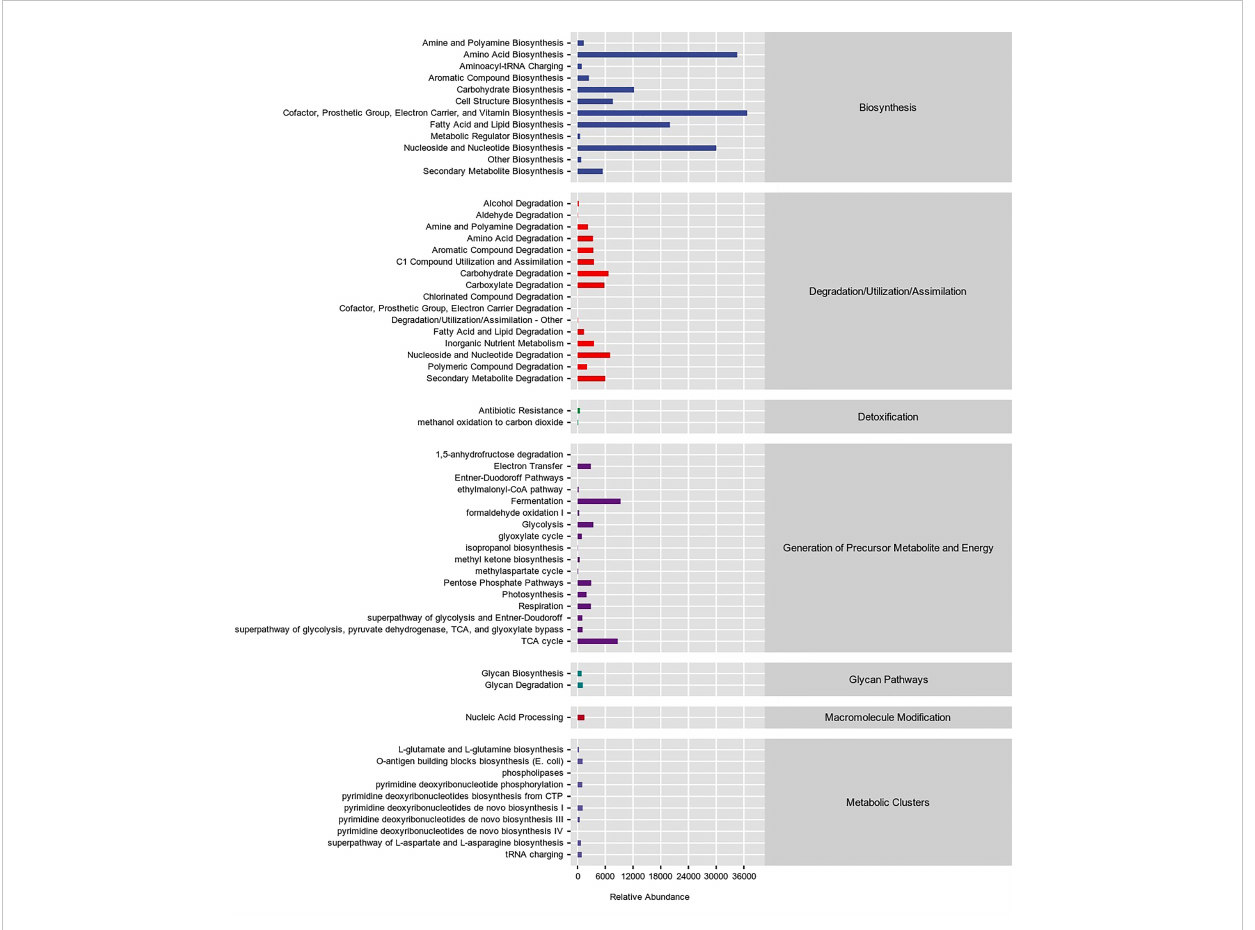
FIGURE 8 Predicting metabolic pathway statistics in interleaf bacterial communities based on the MetaCyc